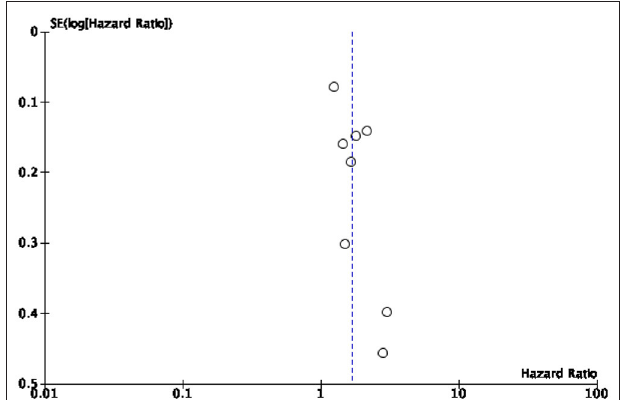
FIGURE 4 | Publication bias for Mortality.